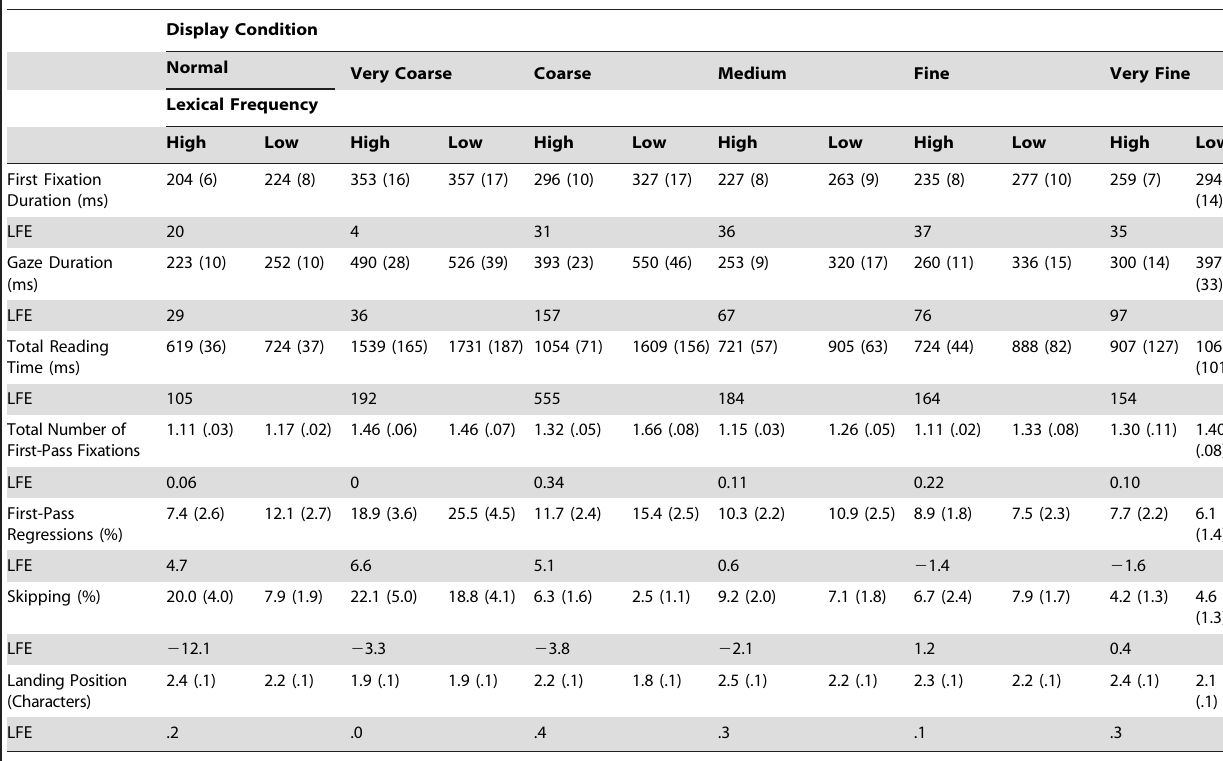
Table 2. Eye Movement Measures for High and Low Frequency Target Words for Each Display Condition.*